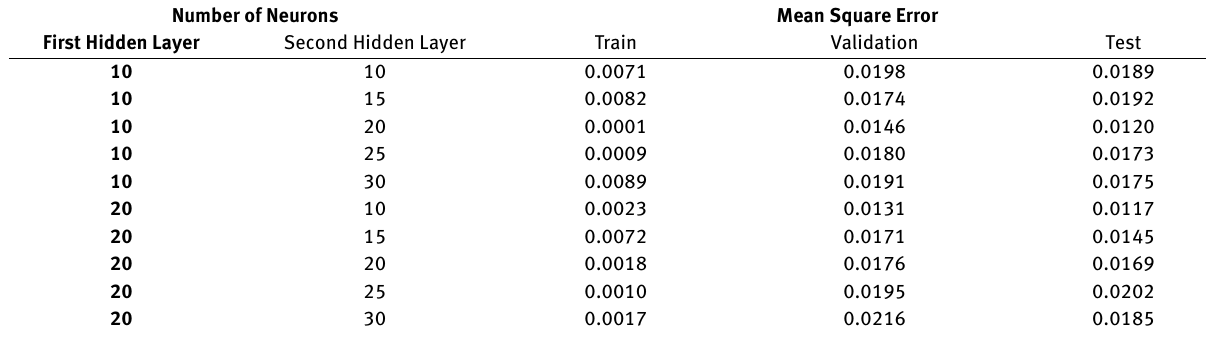
Table 2: MSE and the Hidden layer details